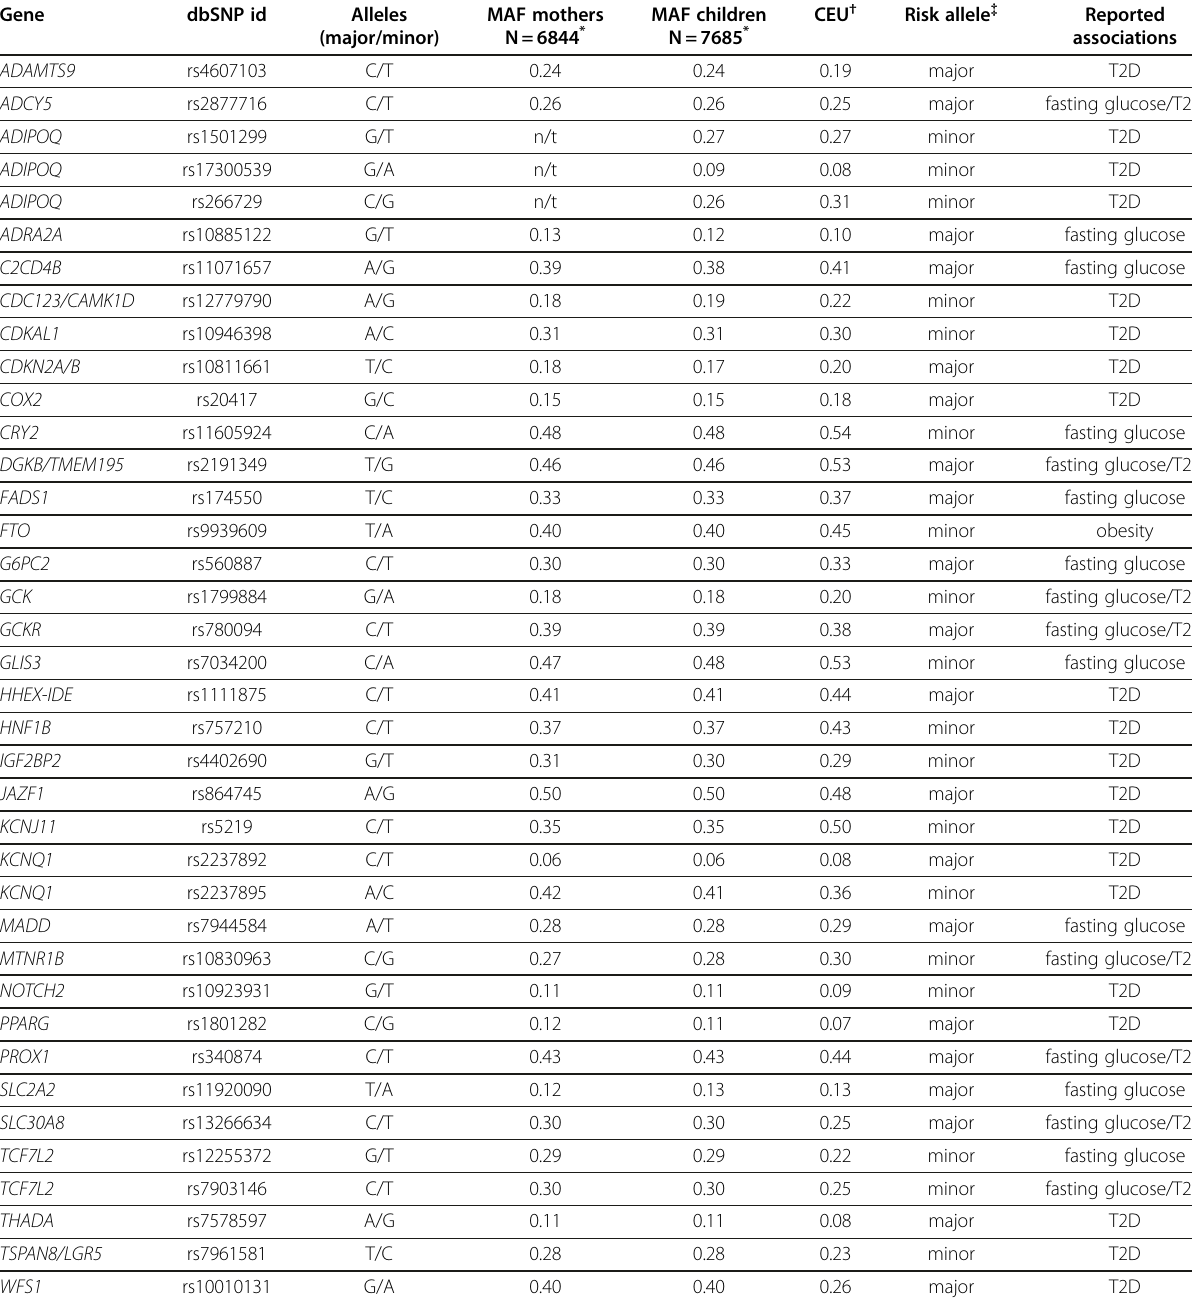
Table 1 Genetic variants related to fasting glucose concentration and type 2 diabetes examined in this